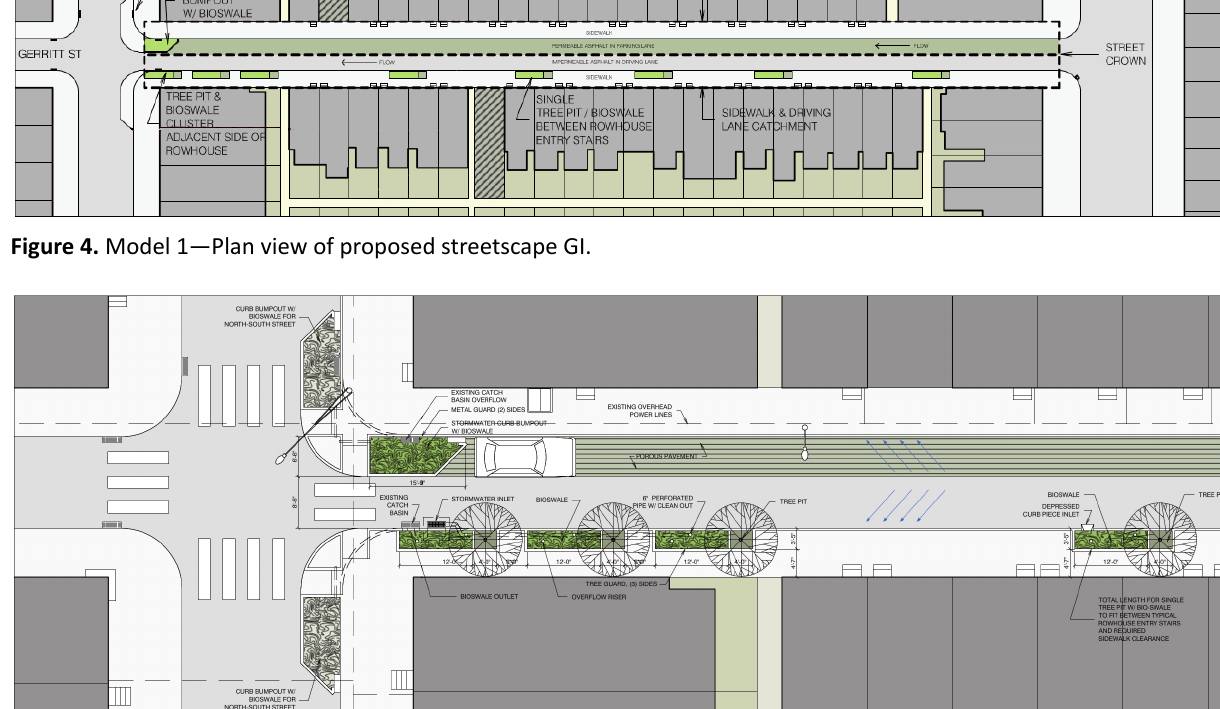
Figure 5. Model 1—Plan view of “gateway” arrangement of GI near the crosswalk and